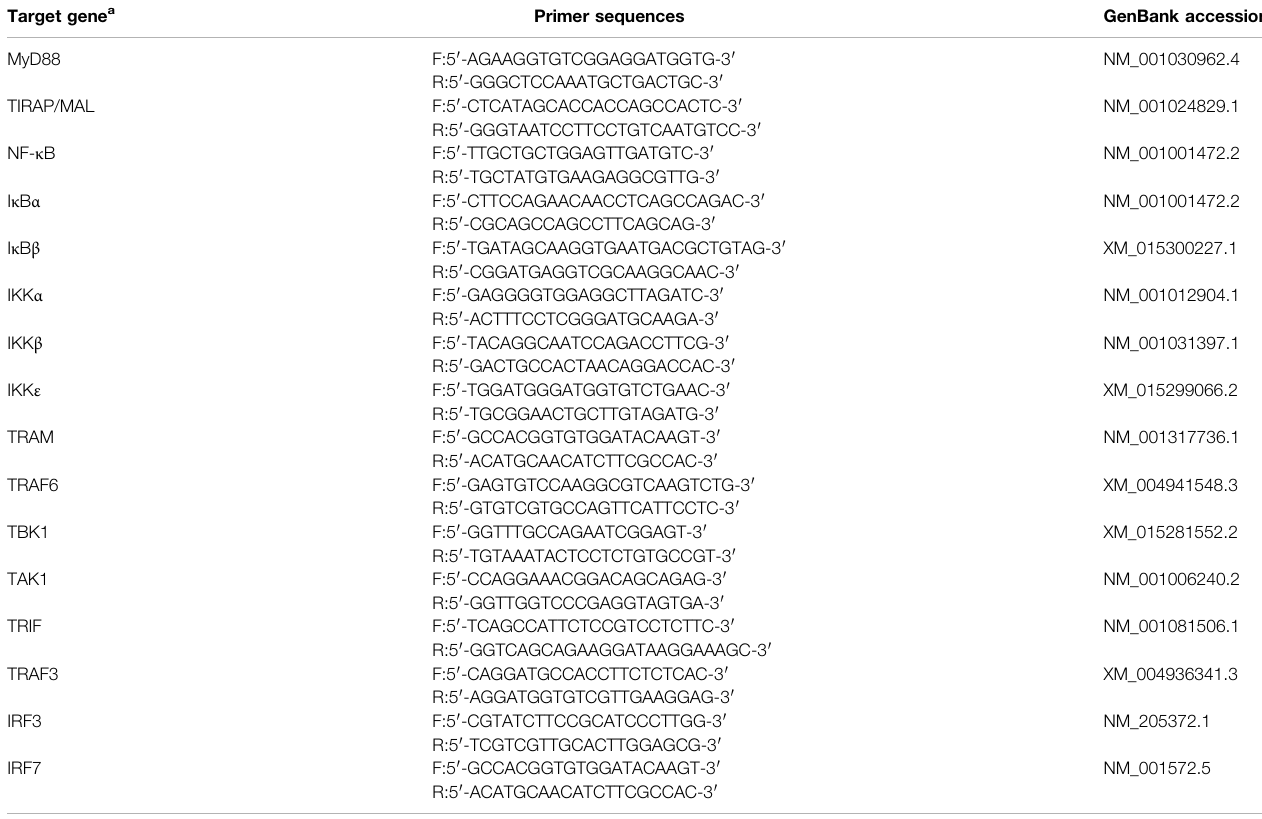
TABLE 5 | Primers of genes related to the Toll-like receptors signaling pathway used for mRNA expression. Target gene a